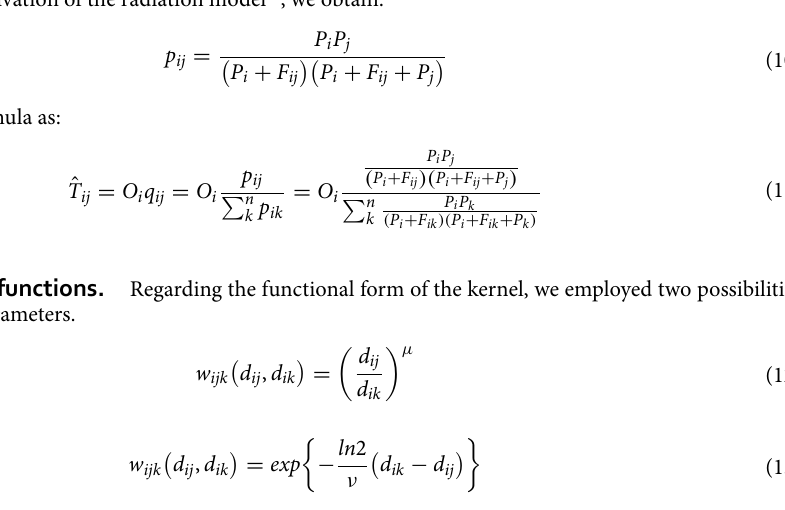
Fig. 3a. The difference between Eqs. (12) and (13) reflects how movers perceive the farther opportunities at area k differently, based on the distance from the destination j . F ij including the opportunities of outer areas if the extent is a smoother function of the distance from the origin by introducing the fuzziness of distance between j and k , w ijk